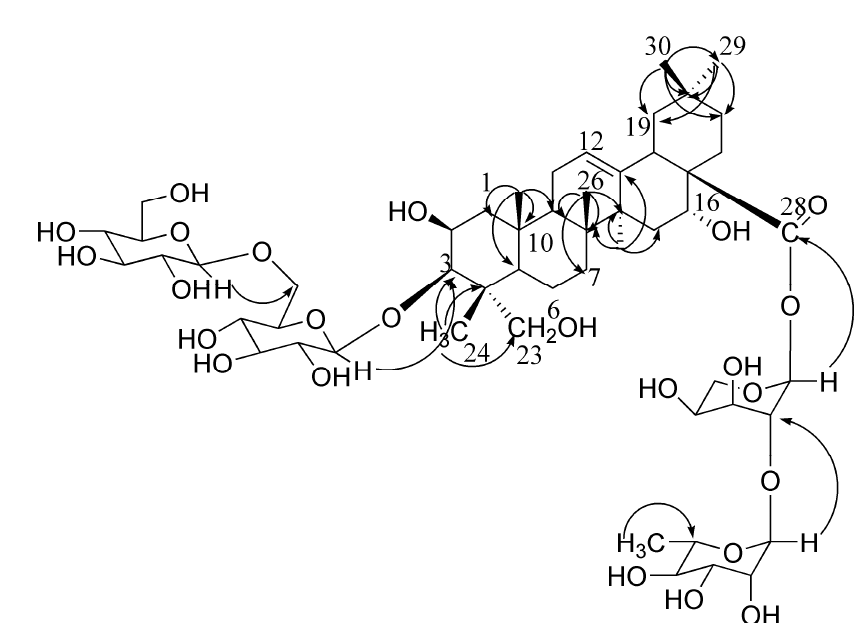
Figure 2. The key HMBC correlations of compound 1 (from H to